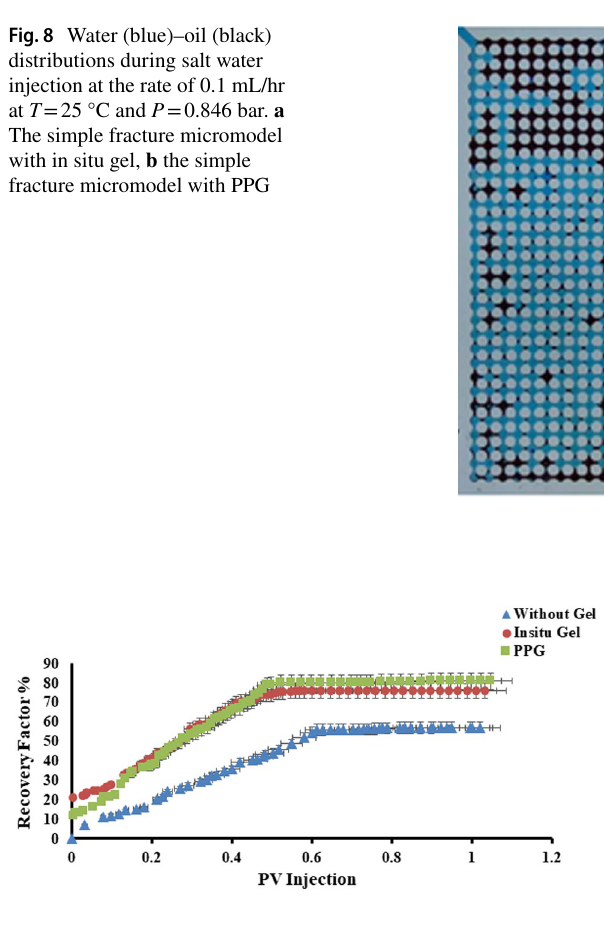
Fig. 9 The amount of oil recovery obtained from a simple fracure micromodel with in situ gel, with PPG and without gel at T = 25 °C and P = 0.846